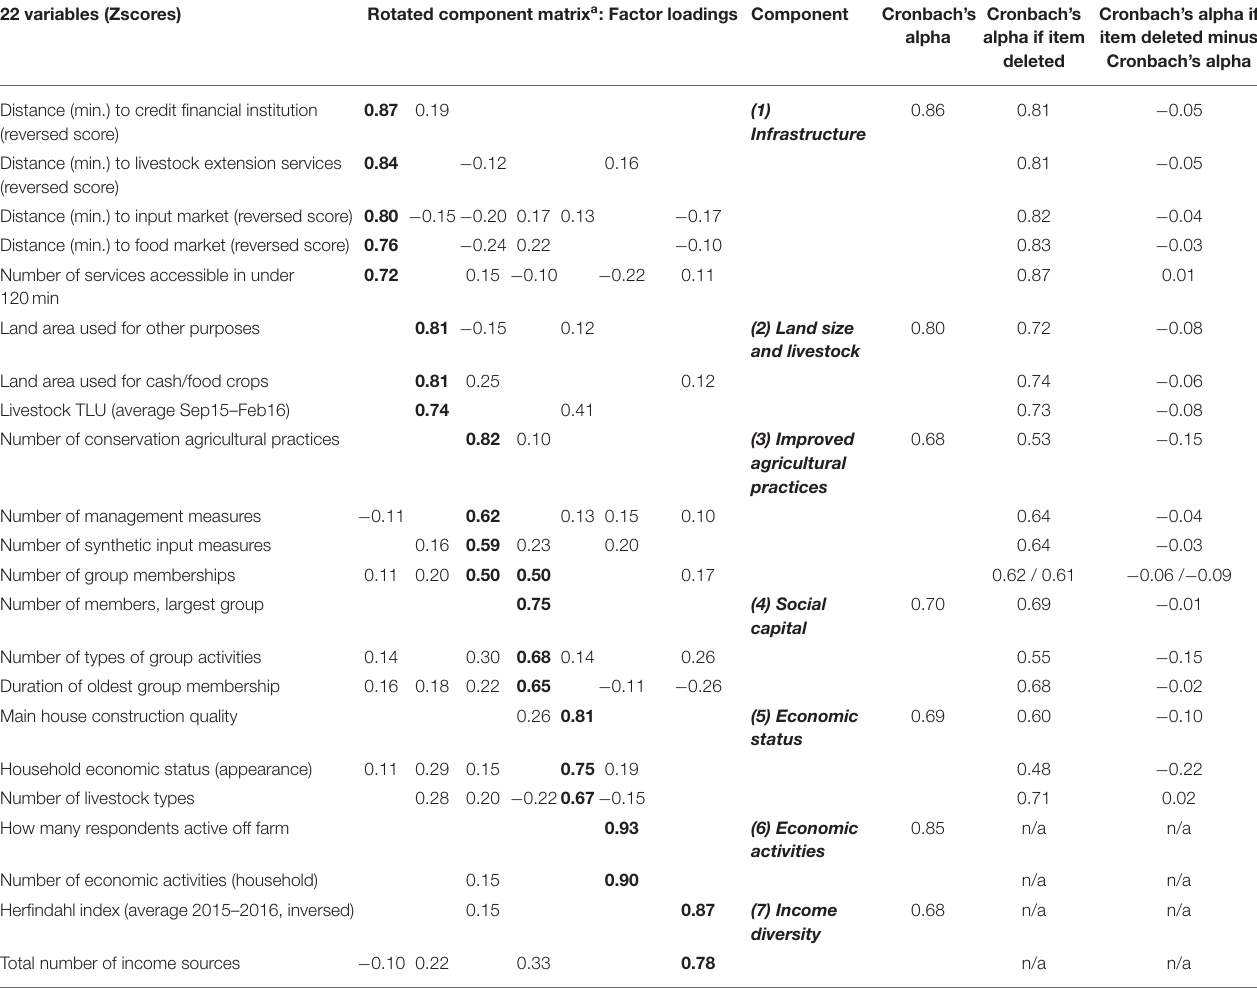
TABLE 2 | Rotated component matrix with factor loadings and reliability analysis results. 22 variables (Zscores) Rotated component matrix a : Factor loadings Component Cronbach’s